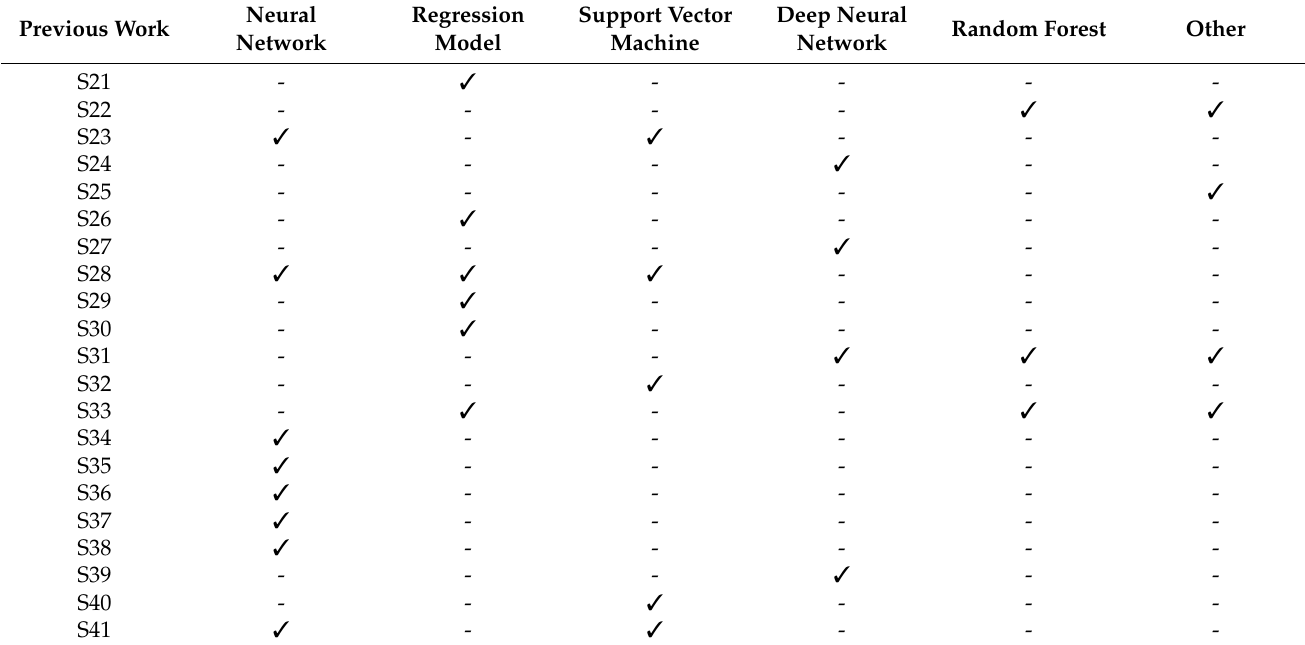
Table A3. Major factors of prediction techniques of energy consumption of buildings.